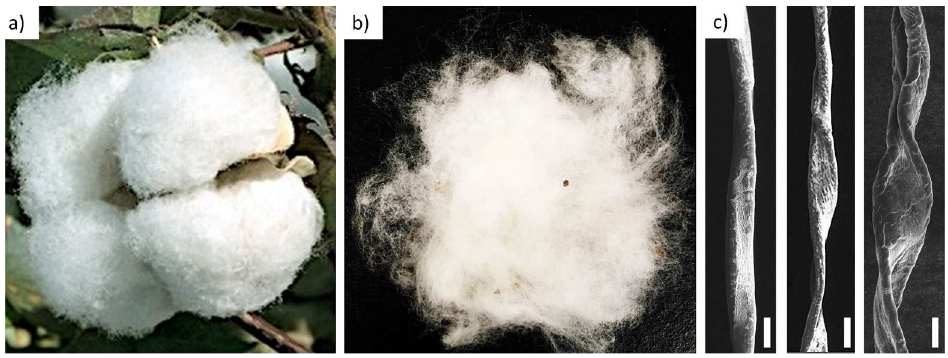
Figure 4. ( a ) Open cotton boll; ( b ) tuft of ginned fiber; ( c ) scanning electron microscopy images of individual cotton fibers. Table 1. Previous studies on frictional properties of cotton fibers ordered by publication